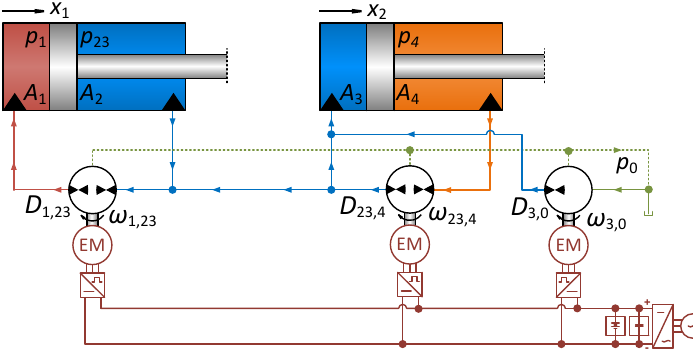
Figure 14. Schematic for VDN-L with interconnection scheme 2 ↔ 1 ↔ 3 ↔ 4, 0 ↔